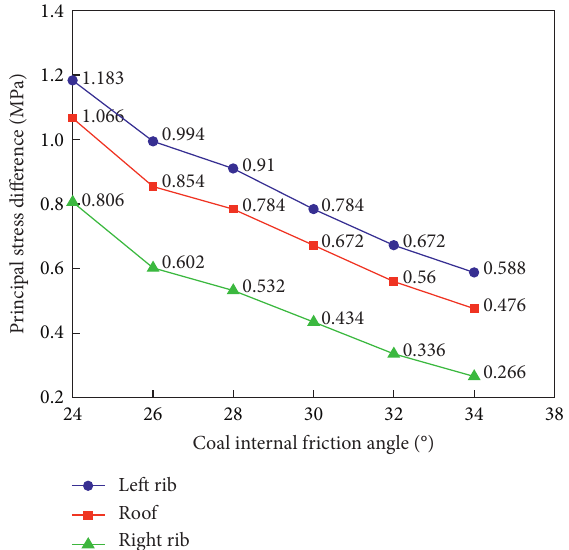
Figure 9: Principal stress difference under different working face lengths of the upper coal